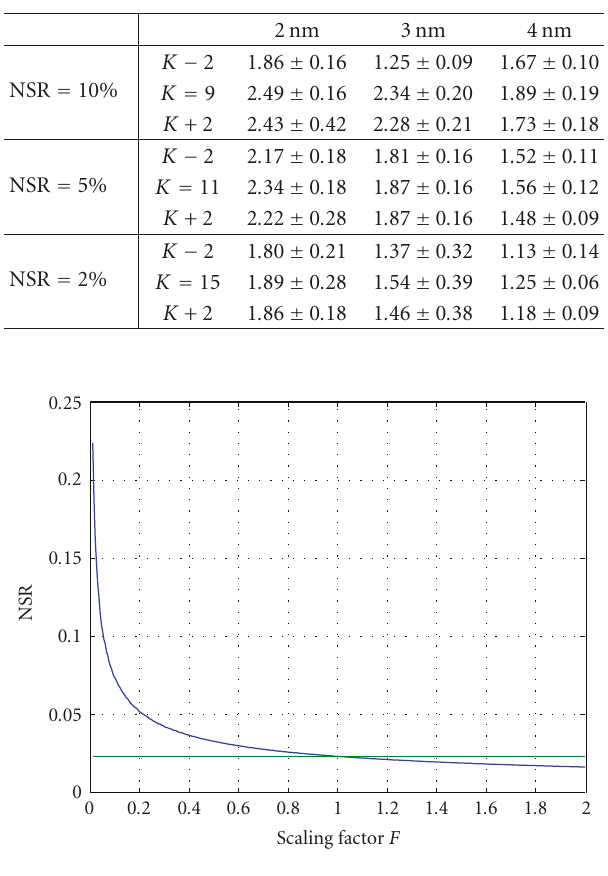
Figure 2: NSR as a function of the factor F , see text for details. The horizontal line separates the NSR values above and below F = 1.